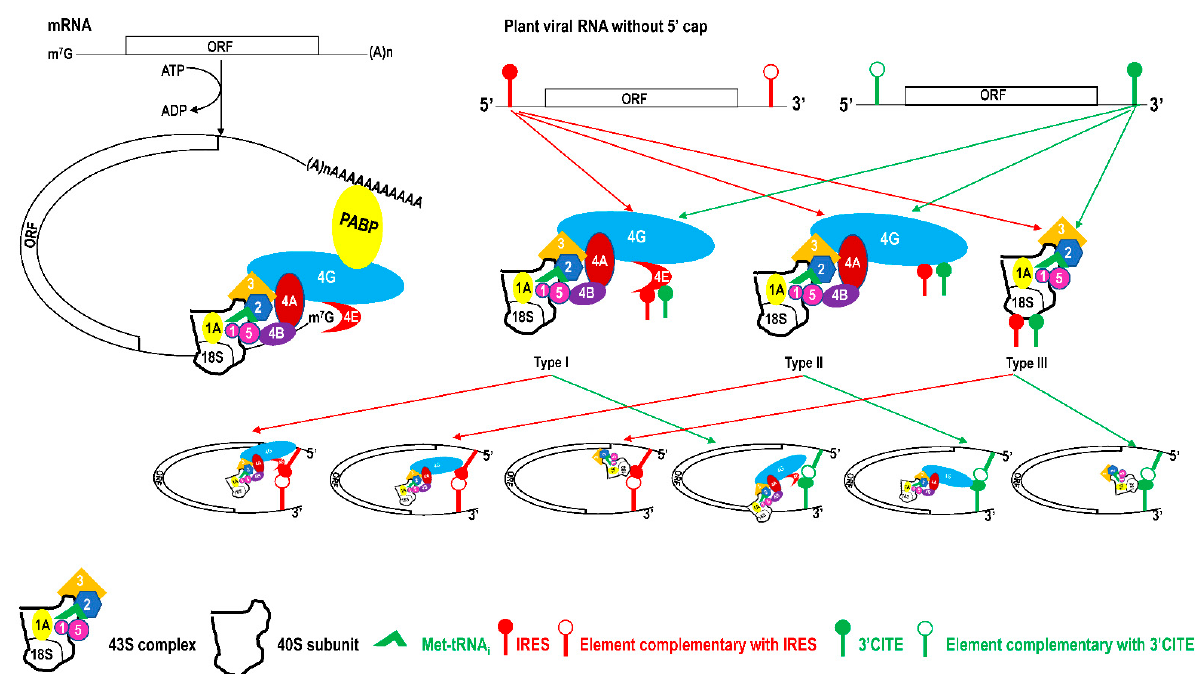
Figure 1. Schematics of translation initiation in cellular mRNA and plant viral RNA without 5 ′ cap. All eukaryotic initiation factors (eIFs) are indicated by number as 1, 1A, 2, 3, 4A, 4B, 4E, 4G, and 5. PABP, poly(A)-binding protein.